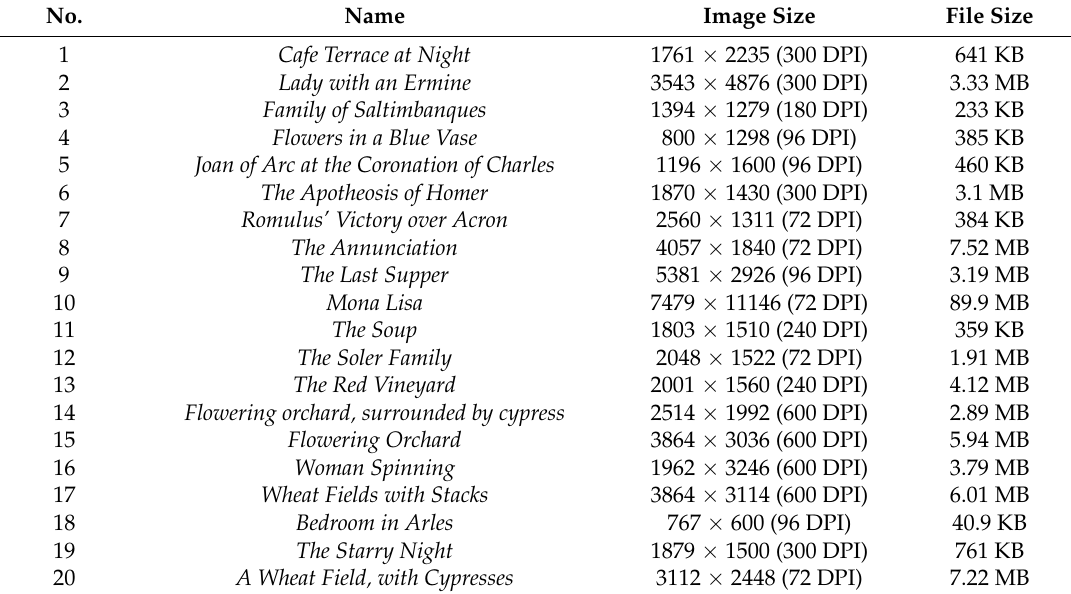
Table 1. Original list of